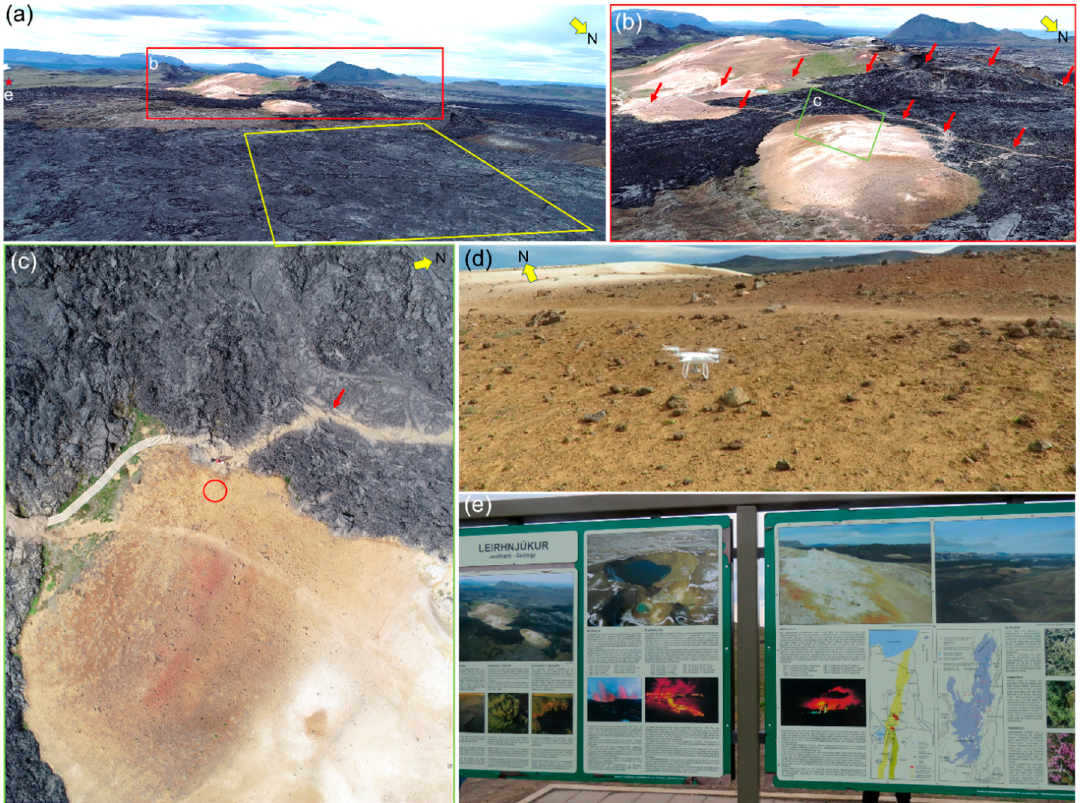
Figure 2. Several of the field photographs: ( a ) aerial shot was taken from the farthest position of the UAV facing the launch site while surveying. The red rectangle provides a context for ( b ). The yellow quadrilateral highlights the area of interest as shown in Figure 1a. The red star near the upper left margin in ( a ) provides a context for ( e ); ( b ) closer shot of the elliptical tourist trail (red arrows) and the launch site (green rectangle); ( c ) Nadir view of the launch site (red circle) and the tourist trail (red arrow); ( d ) UAV during the lift-off from the launch site; ( e ) information board for Leirhnjúkur fissure volcano at the tourist parking site.